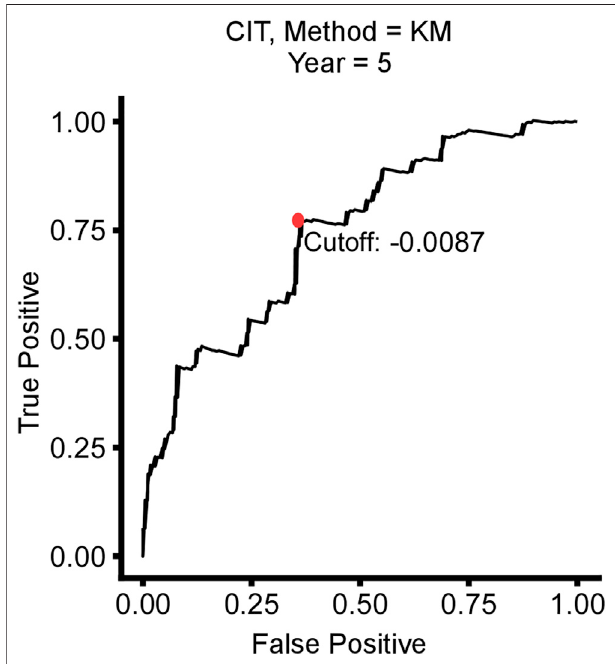
FIGURE 3 | Time-dependent ROC curve for 5-year disease-free survival (DFS) in stage I/II CRC patients in the training